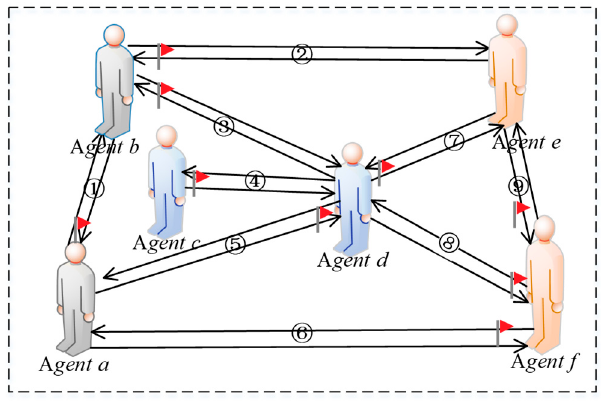
Figure 5. Comparison of interaction revenue.